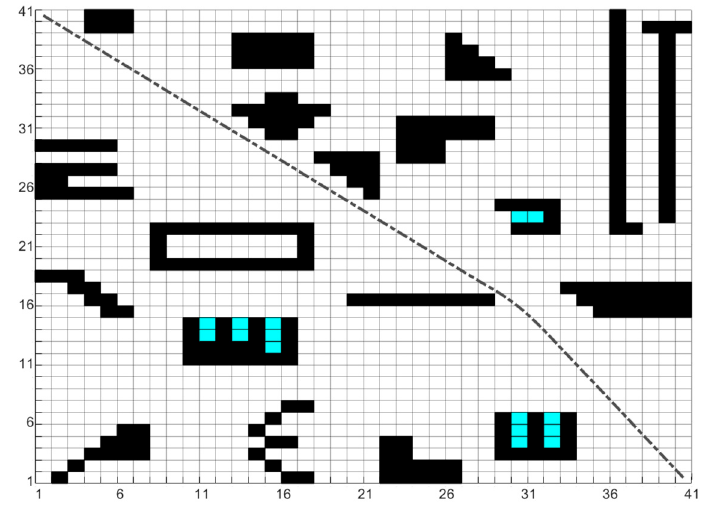
Figure 24. Global optimal path of the robot.